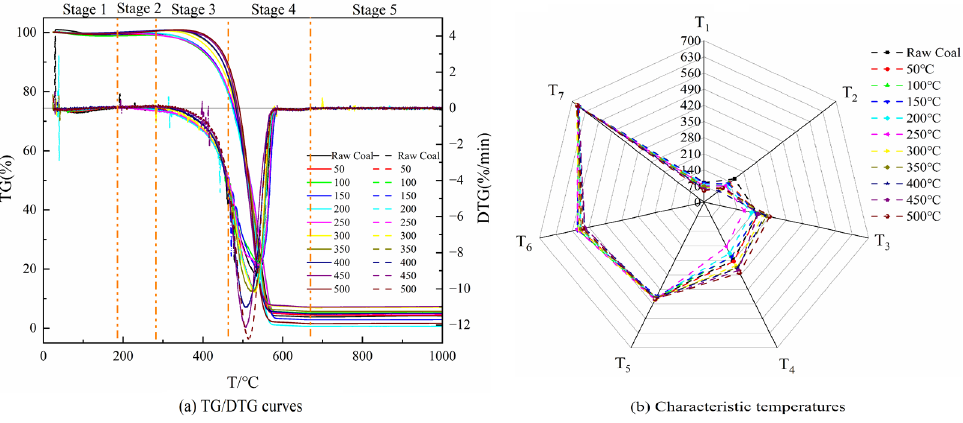
Figure 9. TG/DTG curves ( a ) and characteristic temperatures changes ( b ) of coal samples.